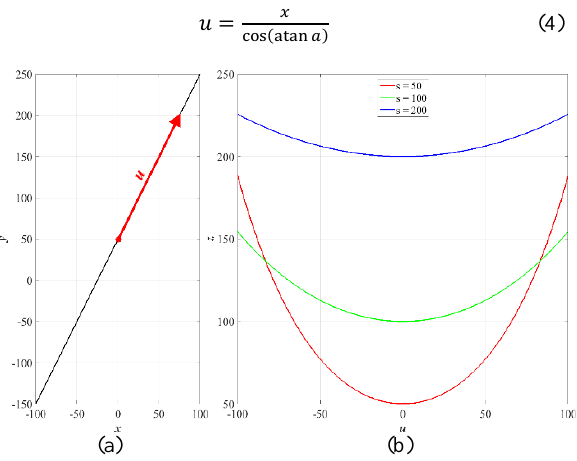
Figure 2. Geometry of the transmission line wire: (a) horizontal, (b) vertical; description in the text Fitting the catenary with the help of the least squares method